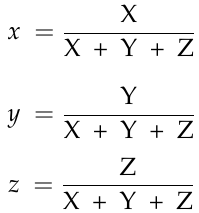
Figure 15. Variation of x , y , and z values against amount of S content. 5. Conclusions In the present study, the synthesis of water soluble CdS x Se 1− x alloy quantum dots by the one-pot method at low temperatures and capped 3-mercaptopropionic acid was reported. The quantum dots